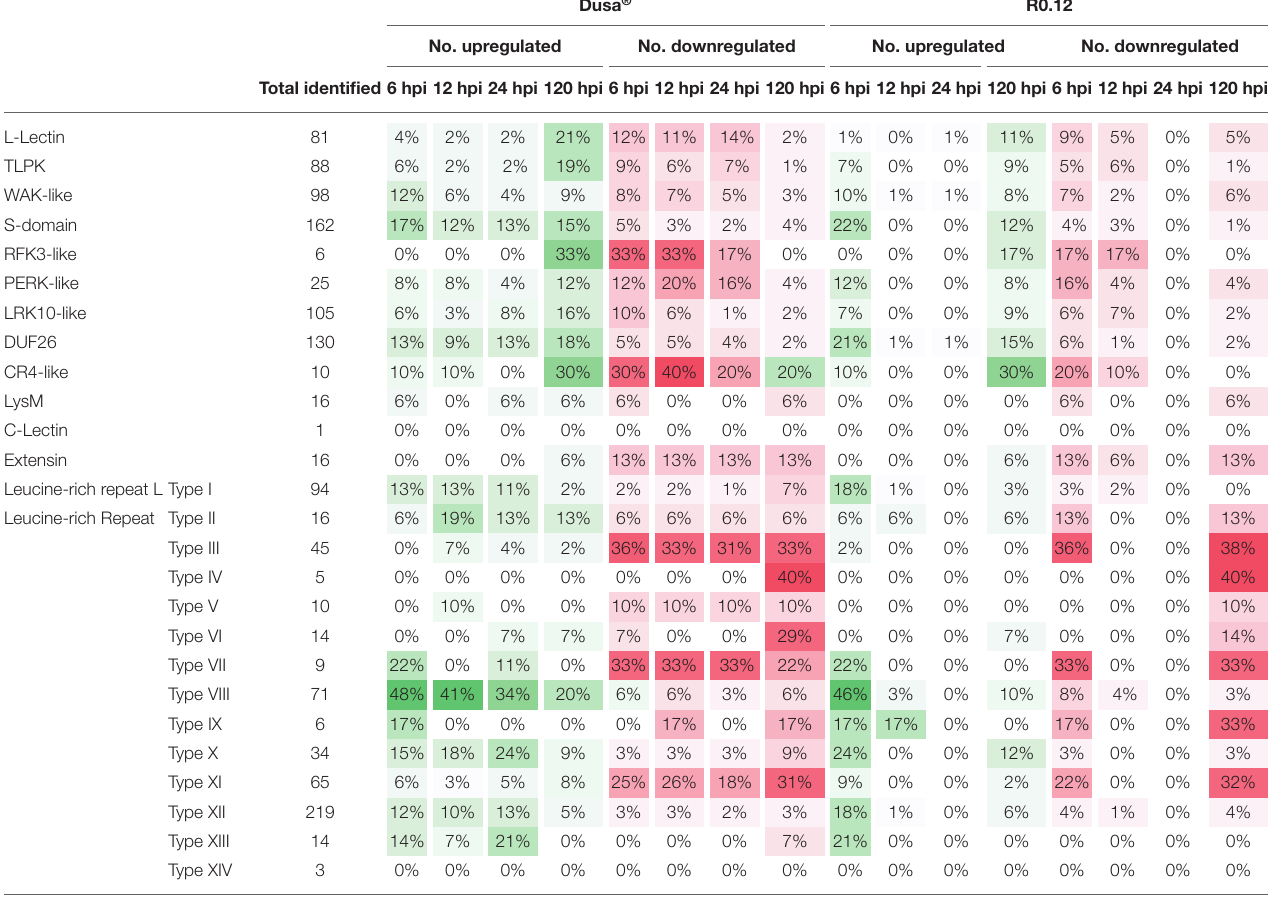
TABLE 4 | Number of predicted receptor-like kinase (RLK) family proteins encoded for by genes that are significantly up- and downregulated in Dusa ® or R0.12 following inoculation with Phytophthora cinnamomi